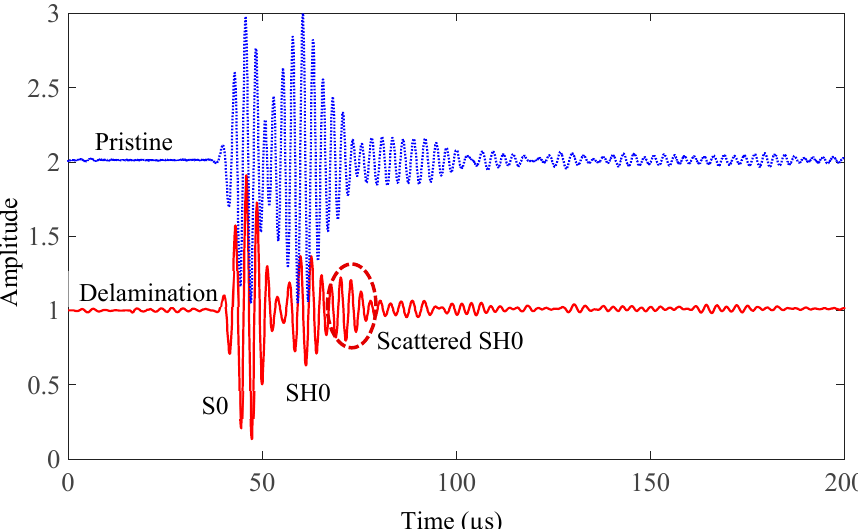
Figure 16. Comparison between the pristine signal and the delamination signal (Scattered S0 is overlapped with incident waves).